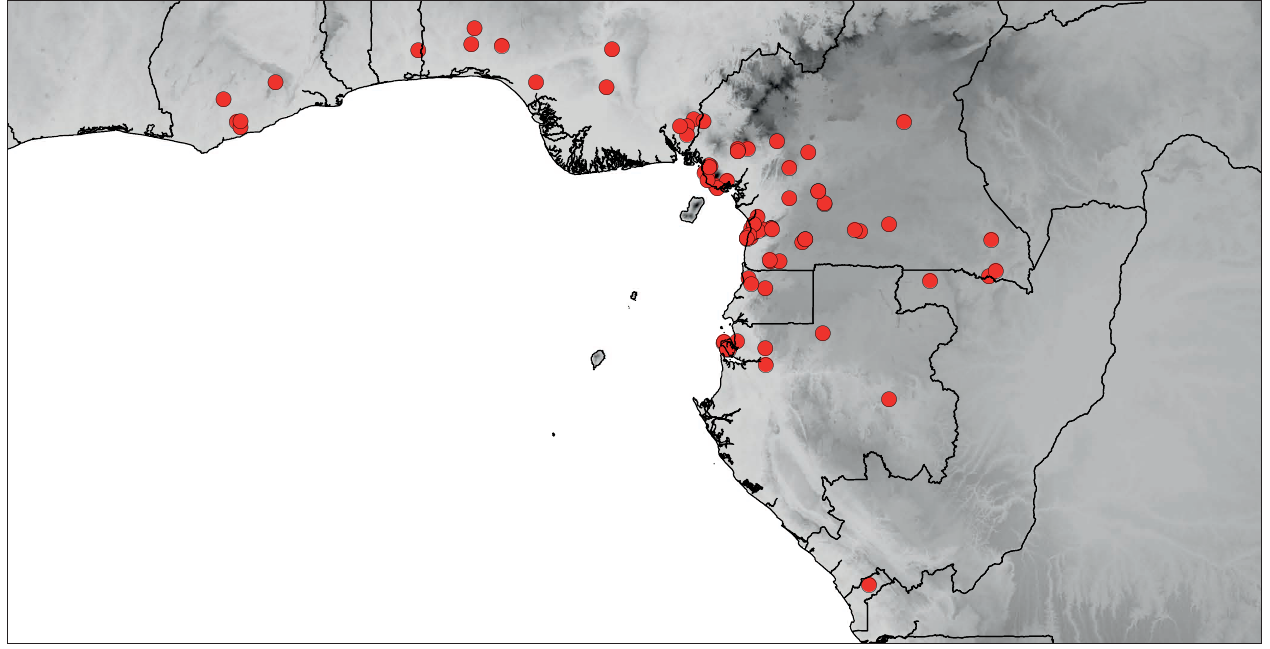
Figure 4 – Distribution of Kolobopetalum auriculatum . Map created with ArcMap 10.7.1 (ArcGIS Desktop v.10.7.1; Esri 2019). © Esri and its licensors, all rights